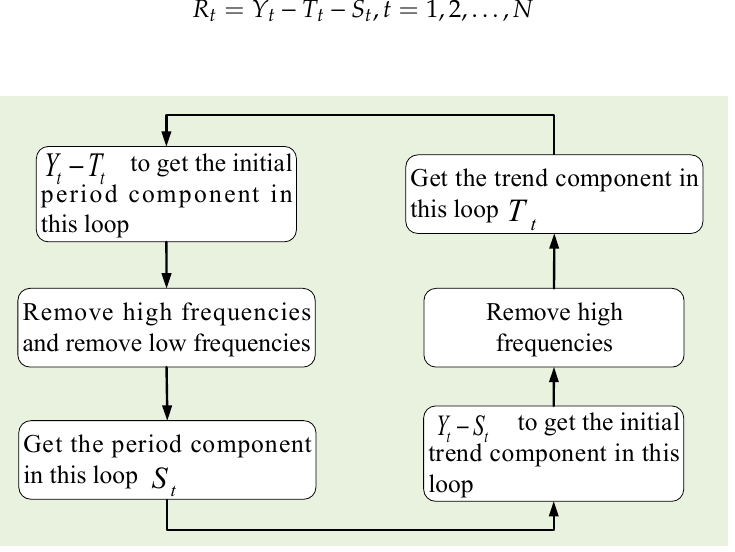
Figure 3. Flowchart of decomposition.